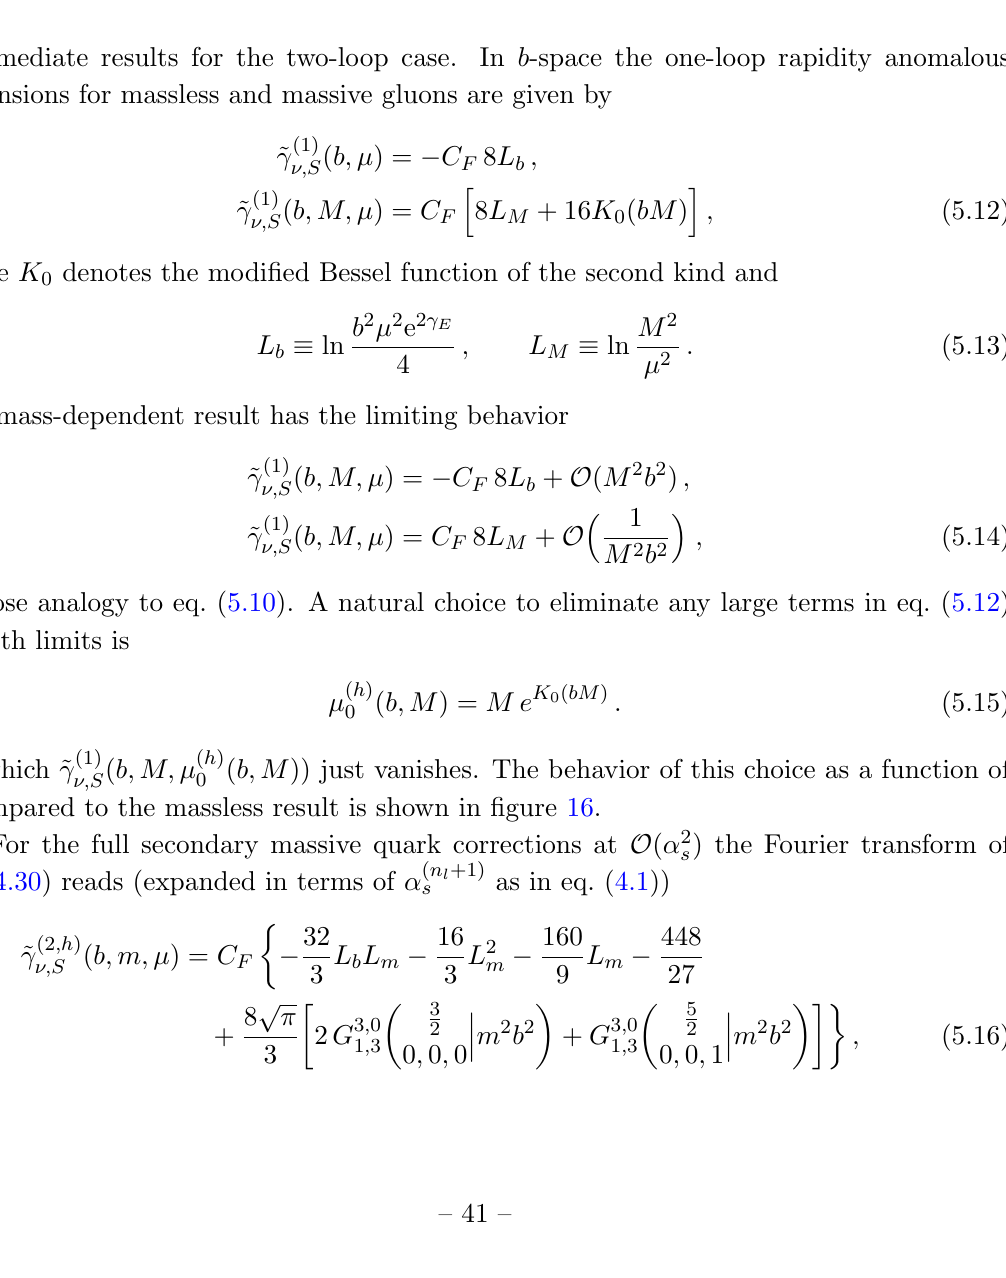
Figure 16 . The canonical scales (cid:22) ( h ) 0) for the massless case (blue, dashed) with M = 5